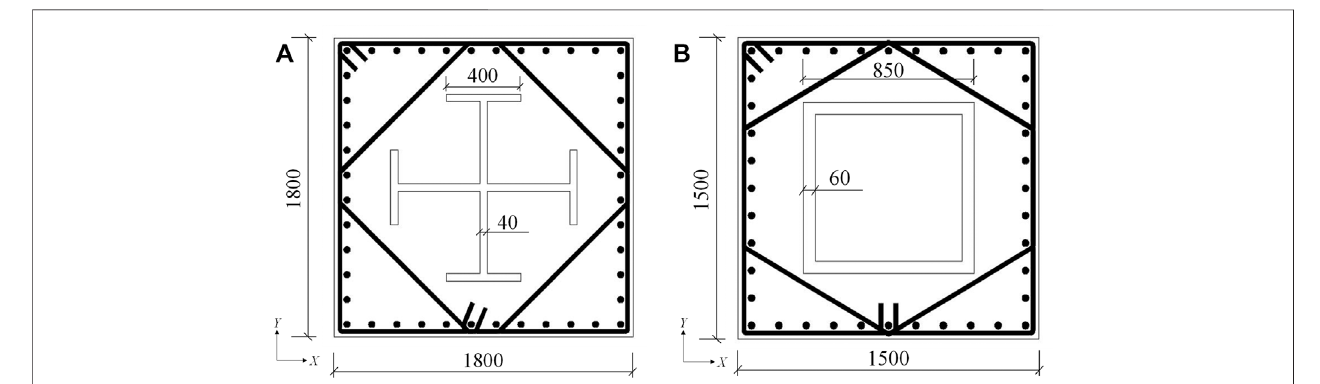
FIGURE 2 | Sections of typical SRC columns (mm). (A) Cross-shaped. (B)